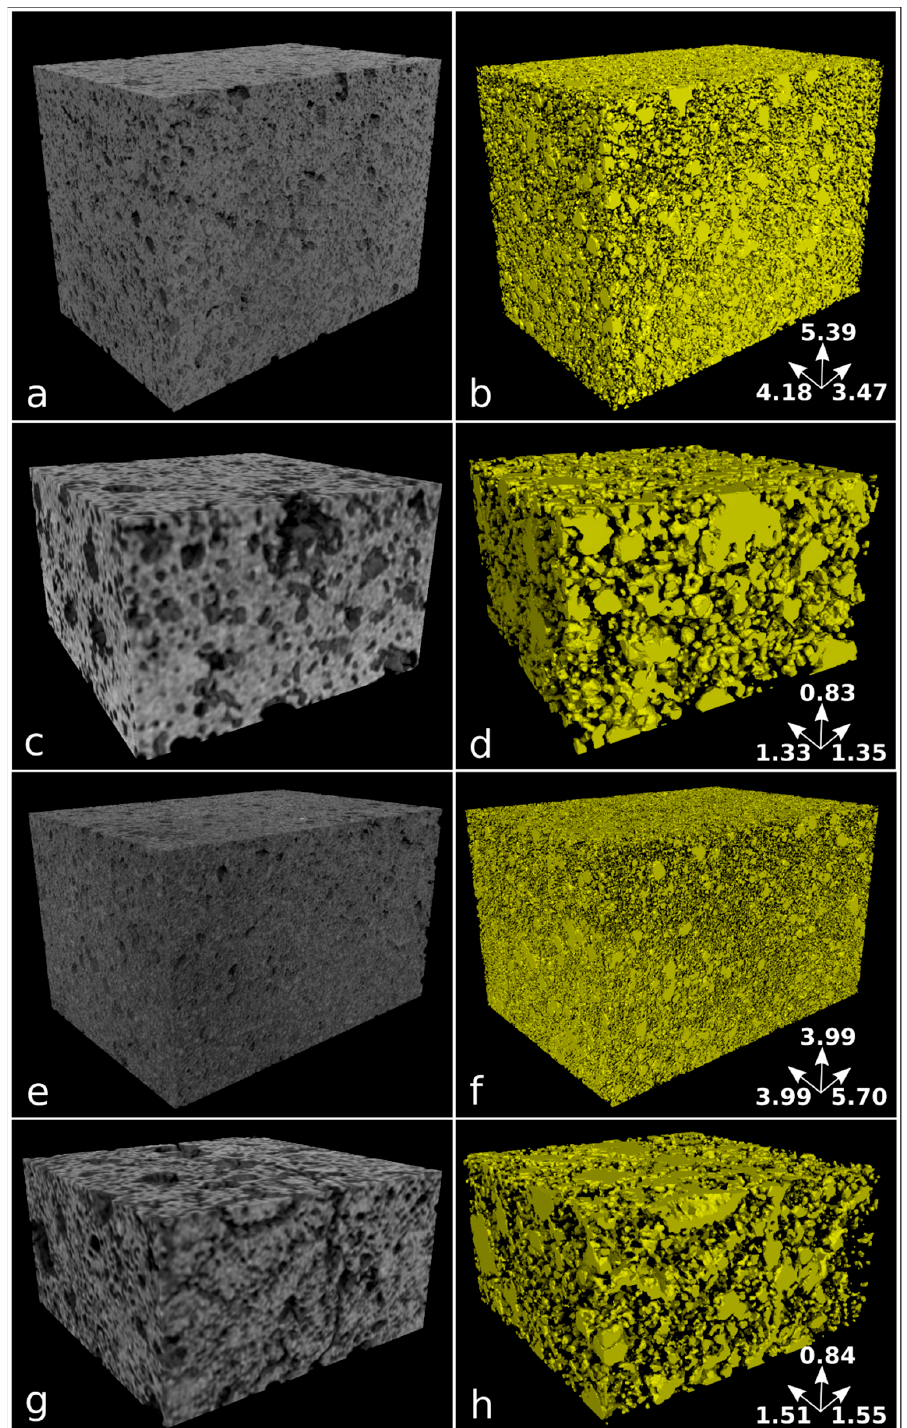
Figure 7. Volume renderings of the extracted VOIs from reconstructed images (left column) and corresponding iso-surface renderings of the pore phase in yellow (right column) for samples nPC1450d ( a , b ), PC1450c ( c , d ), nPC1350d ( e , f ), and PC1350c ( g , h ). Samples nPC1450d and nPC1350d have been reconstructed with an isotropic voxel size of 5.7 μ m, while an isotropic voxel size of 5.0 μ m has been used for samples PC1450c and PC1350c. The size of analyzed VOIs is reported in Table 2. The dimension of the sample edges is reported in mm.